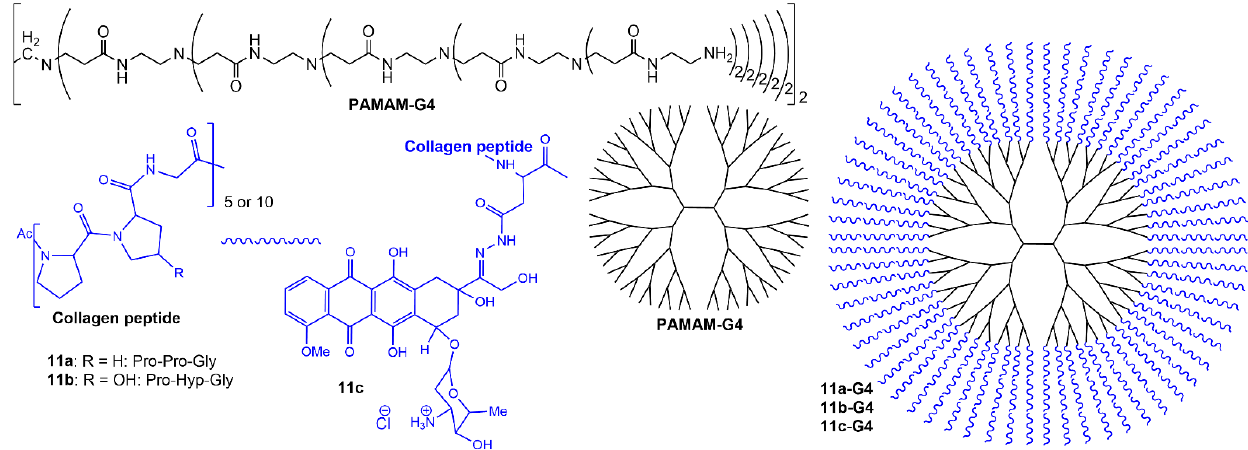
Figure 9. PAMAM dendrimers functionalized with collagen mimetics.